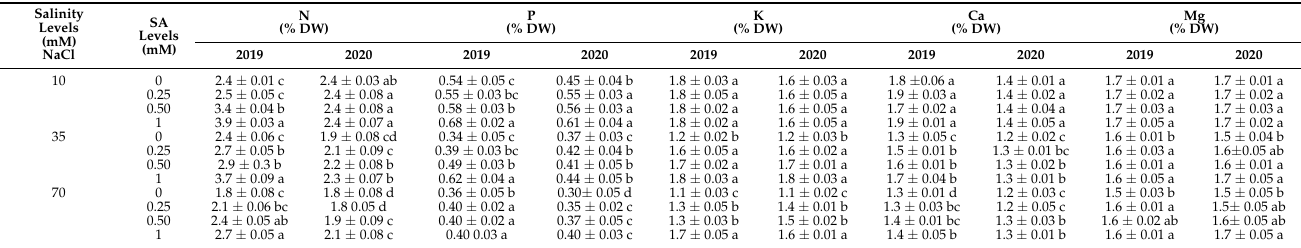
Table 5. Means of leaf nitrogen (N), phosphorus (P), potassium (K), calcium (Ca), and magnesium (Mg) of pomegranate plants in response to foliar salicylic acid (SA) treatments under salinity stress